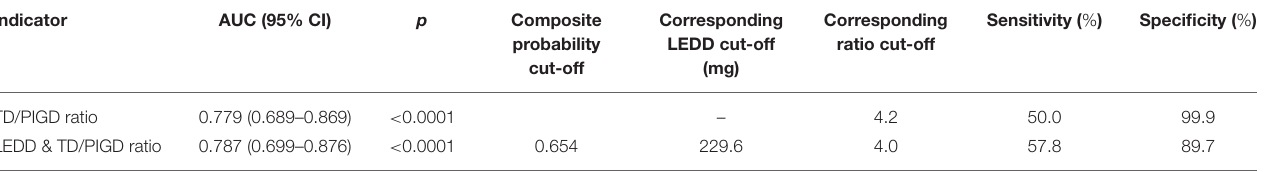
TABLE 3 | Receiver operating curve (ROC) analysis for subtype